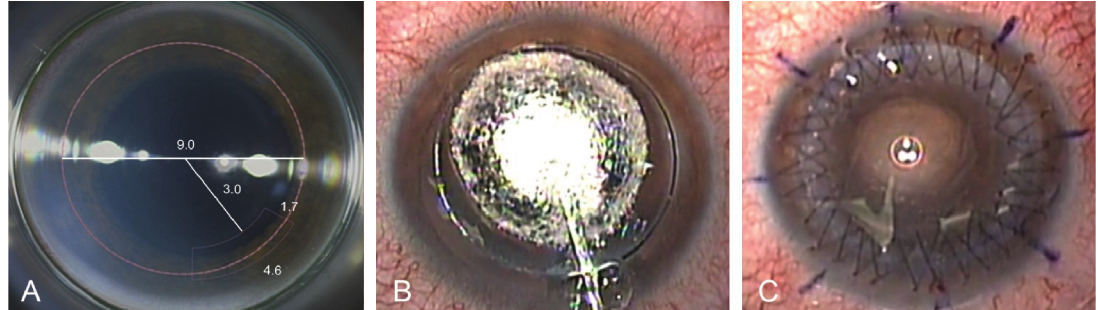
Figure 1: Intraoperative and postoperative images of a representative patient who underwent femtosecond laser- (FSL-) assisted big-bubble deep anterior lamellar keratoplasty: (a) shape and size of FSL incisions; (b) successful formation of big bubble; (c) end of the surgery with keratoscopy control of final